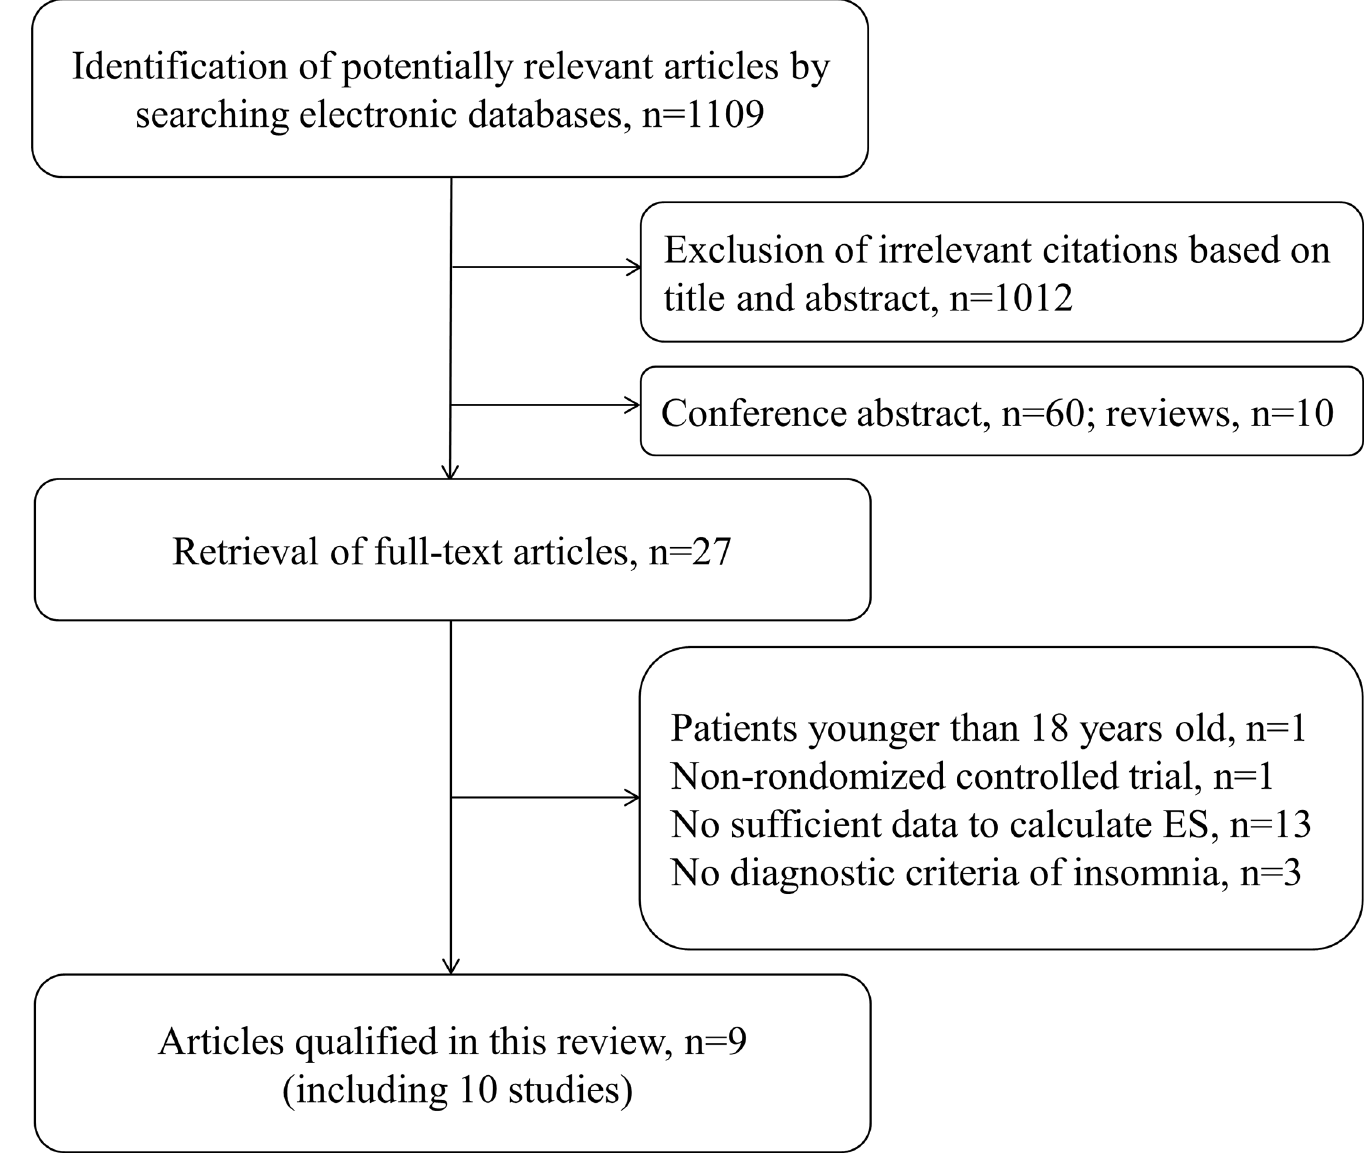
Fig 1. Flow diagram of the qualified